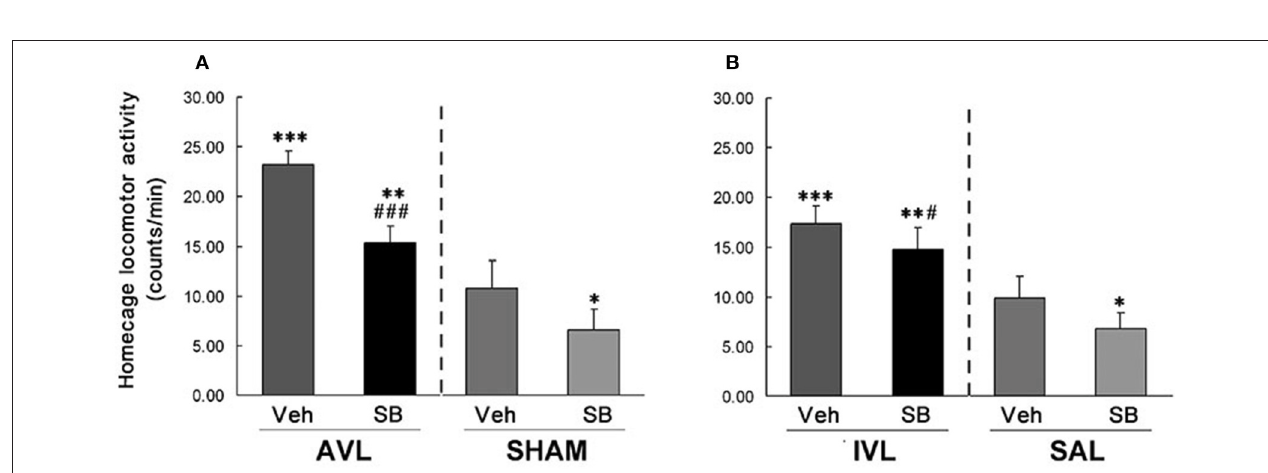
FIGURE 2 | Effects of the orexin receptor type 1 (OX 1 R) antagonist SB334867 on the vestibular deficit syndrome after vestibular lesions induced by arsanilate (A) and IDPN (B) in rats. AVL, arsanilate - induced vestibular lesion; SHAM, sham control; IVL, IDPN - induced vestibular lesion; SAL, saline control; Veh, vehicle solution; SB, SB334867. Data are represented as mean ± SEM. *** P < 0.001 compared with SHAM or SAL, vehicle control group; ### P < 0.001 compared with AVL or IVL vehicle control group.